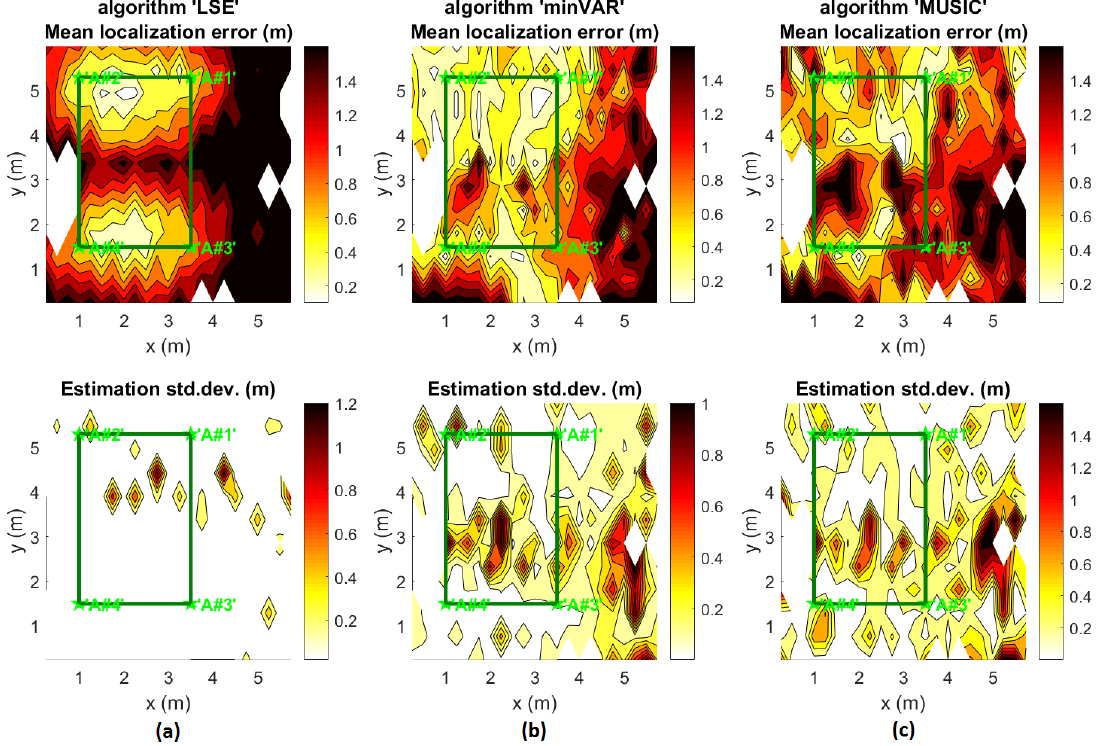
Figure 15. Distributed localization error over ( x , y ) with N = 100 trials per